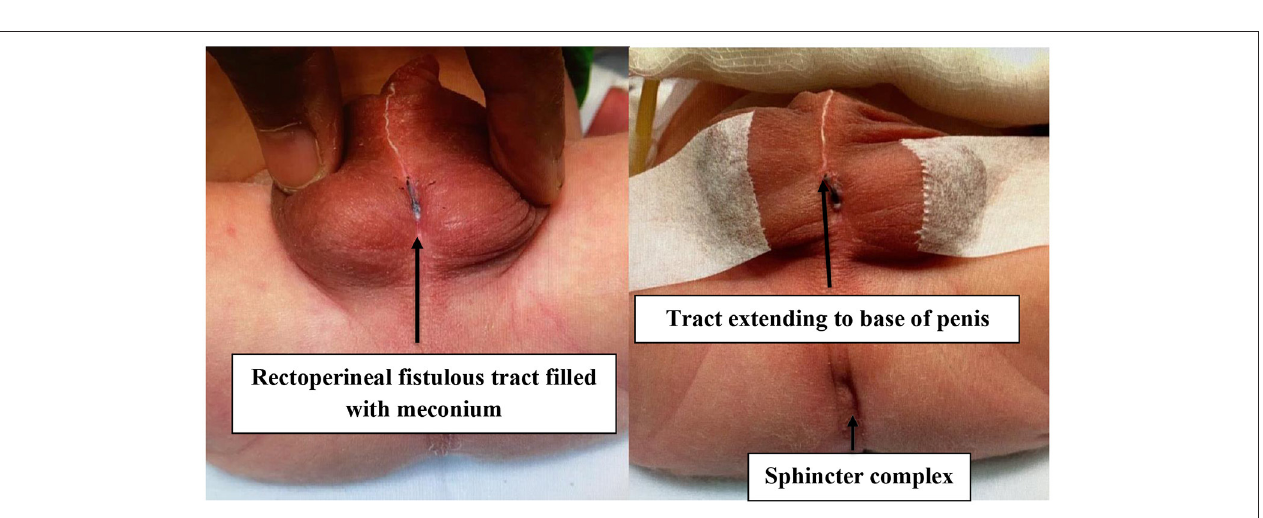
FIGURE 5 | The baby was initially planned for perineal anoplasty on day 2 of life. It was noted there was a fine, long cutaneous track running in the scrotal raphae in close proximity with the bulbar urethra extending all the way to the base of the penis. The bulbar urethra was inadvertently entered during separation of the thin common wall. This was repaired in two layers. Anoplasty was then